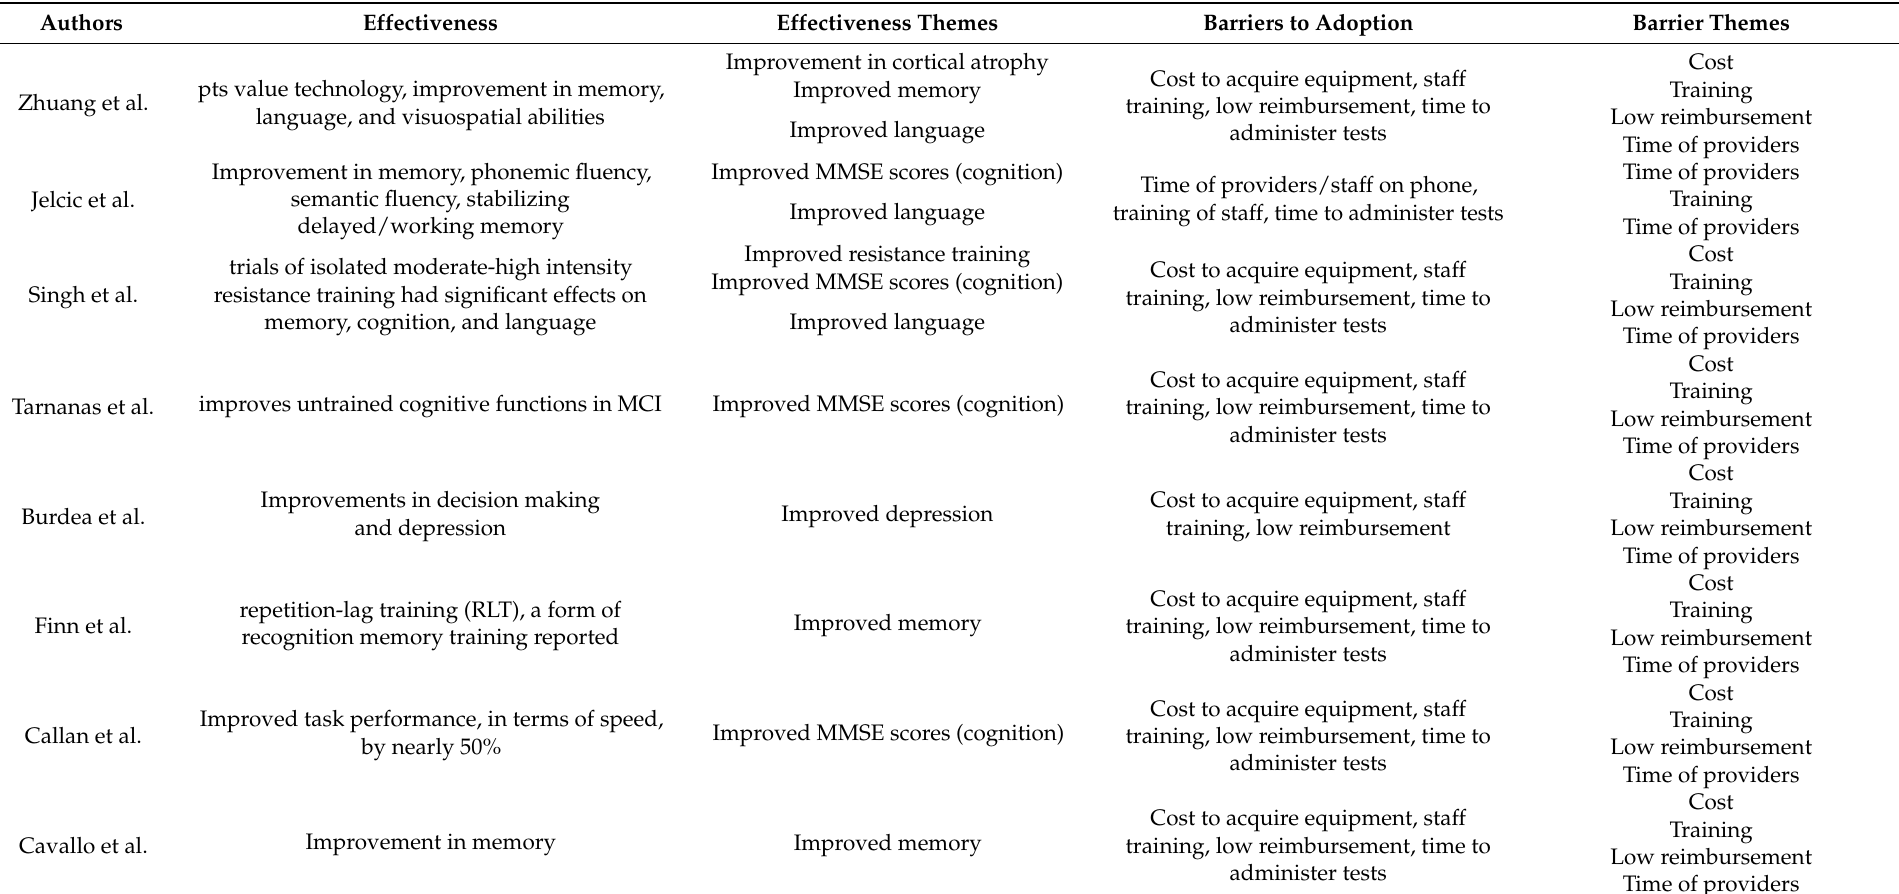
Table A2. Observation-to-theme conversion (Effectiveness and Barriers to